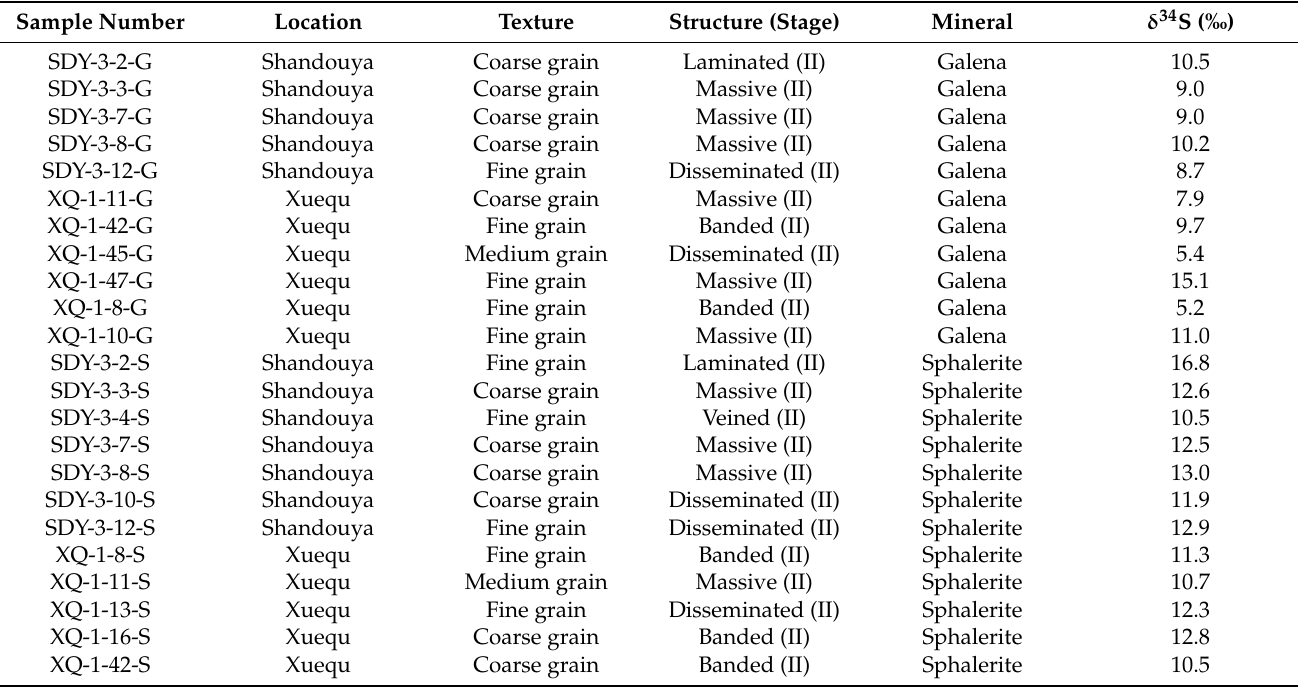
Table 3. Sulfur isotope analytical results of metal sulfide